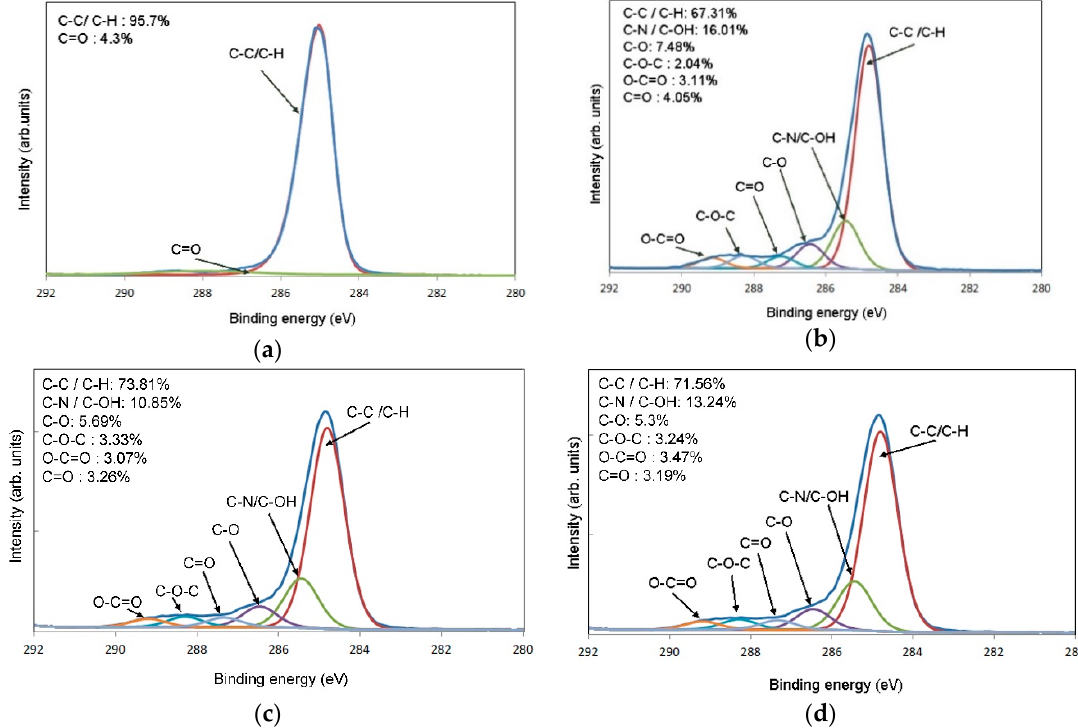
Figure 5. High resolution C1s spectra of ( a ) untreated and air treated samples with different power inputs: ( b ) 50 W, ( c ) 125 W and ( d ) 200 W.